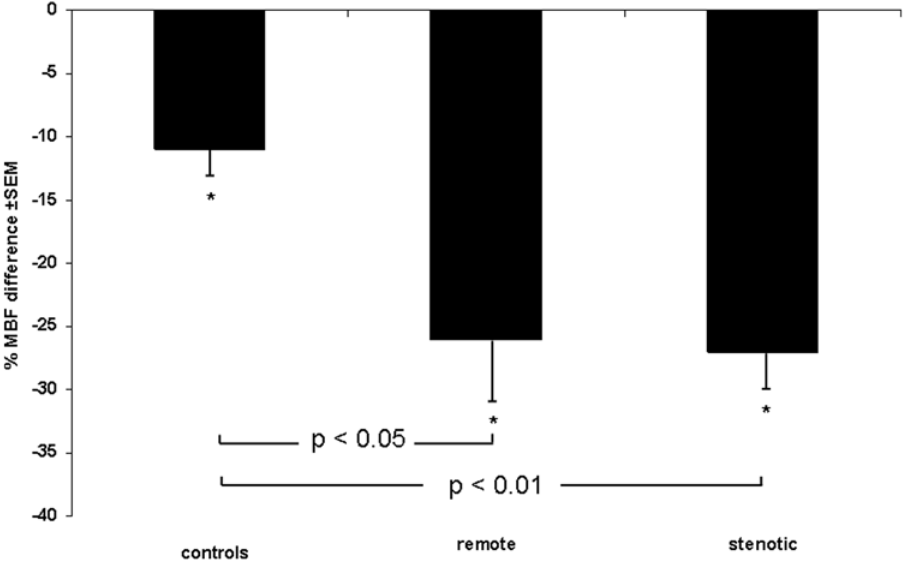
Figure 1. Exercise-induced hyperemia: effects of caffeine. Caffeine decreases exercise-induced hyperaemic MBF. This effect was most prominent in stenotic segments of CAD patients. * P , 0.005 for the comparison versus